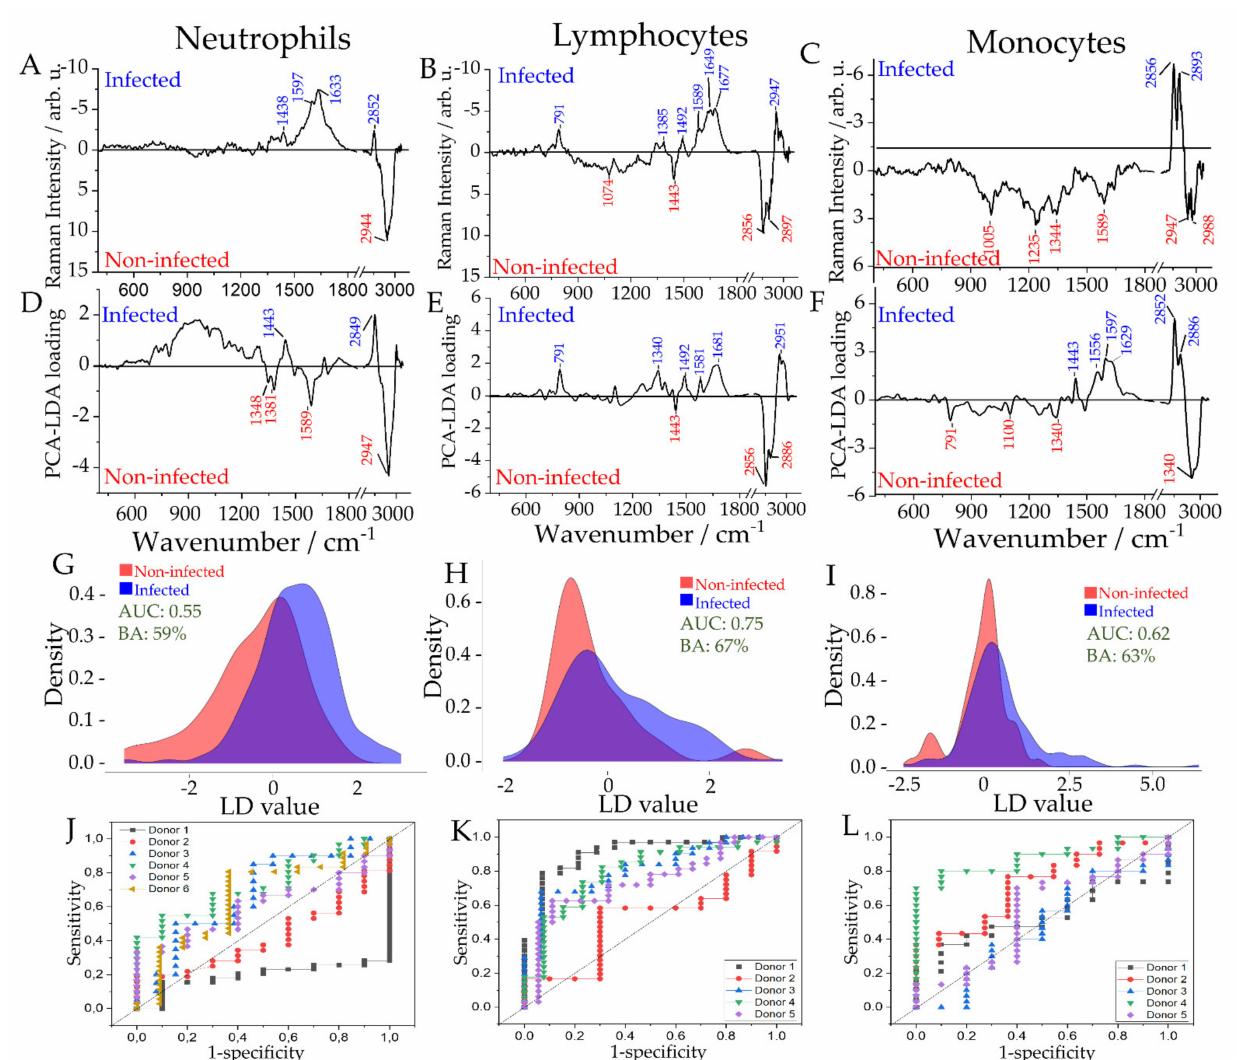
Figure 2. Raman spectroscopic analysis of in vitro stimulation of leukocyte subpopulations and statistical analysis to differentiate infected and non-infected cells. Each leukocyte subpopulation was infected individually with the heat- inactivated pathogens: K. pneumoniae , S. aureus , and C. albicans . Analysis of the infected cells was performed collectively for each leukocyte subpopulation. Raman difference spectra ( A – C ), PCA loadings ( D – F ), distribution of fitted LD model scores ( G – I ), and ROC curves for the cross-validated predictions ( J – L ) are given for neutrophils ( A , D , G , J ), lymphocytes ( B , E , H , K ) and monocytes ( C , F , I , L ). The ROC curves ( J – L ) are calculated for each donor. Achieved balanced accuracy (BA) on the sample level and average AUC on the cell level are used as metrics for the PCA-LDA models are given as insets to the distribution of fitted LD model scores ( G – I